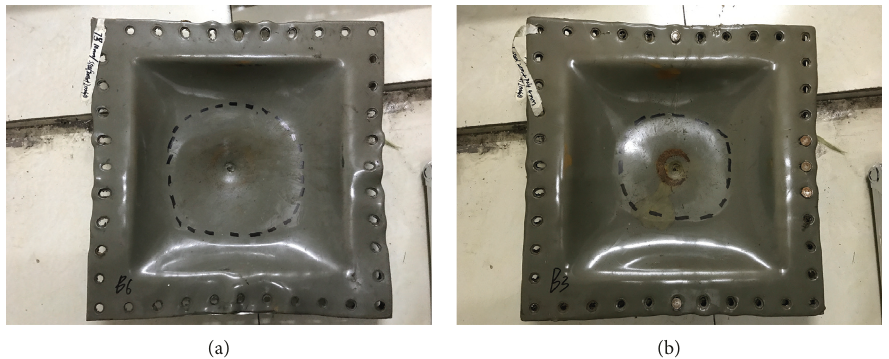
Figure 6: Front faces of steel plates with the polyurea layer on the front surface after tests. (a) 2mm polyurea coating ( ∼ 260 mm diameter of unbonded layer). (b) 4mm polyurea coating ( ∼ 210mm diameter of unbonded layer).